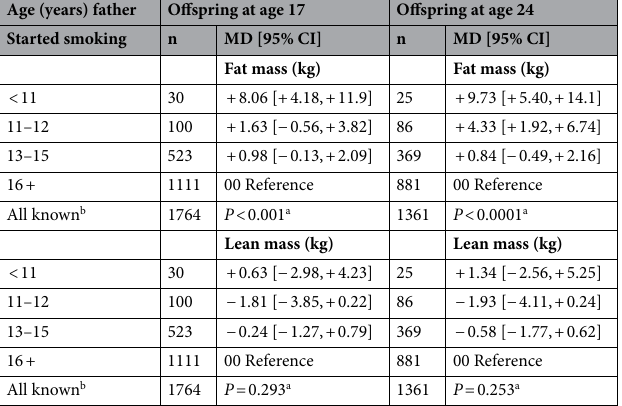
Table 1. Unadjusted associations between mean fat mass of the F3 (probands) population according to age at which their fathers (F2) had started smoking regularly; only families where the study father had smoked are included. CI, Confidence interval; MD, mean difference. a P for trend. b All smokers with known age at onset.